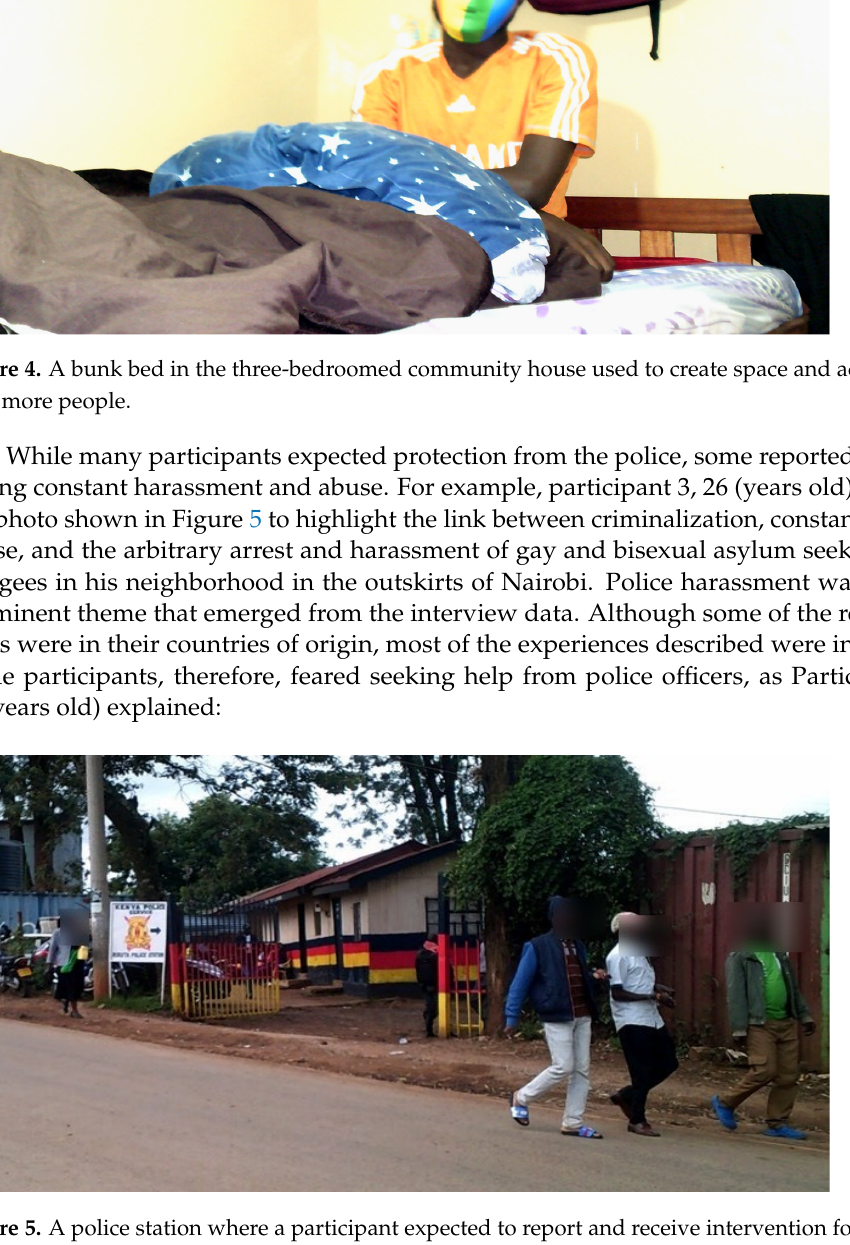
Figure 3. A community house that houses many refugees. The house is always full and congested.